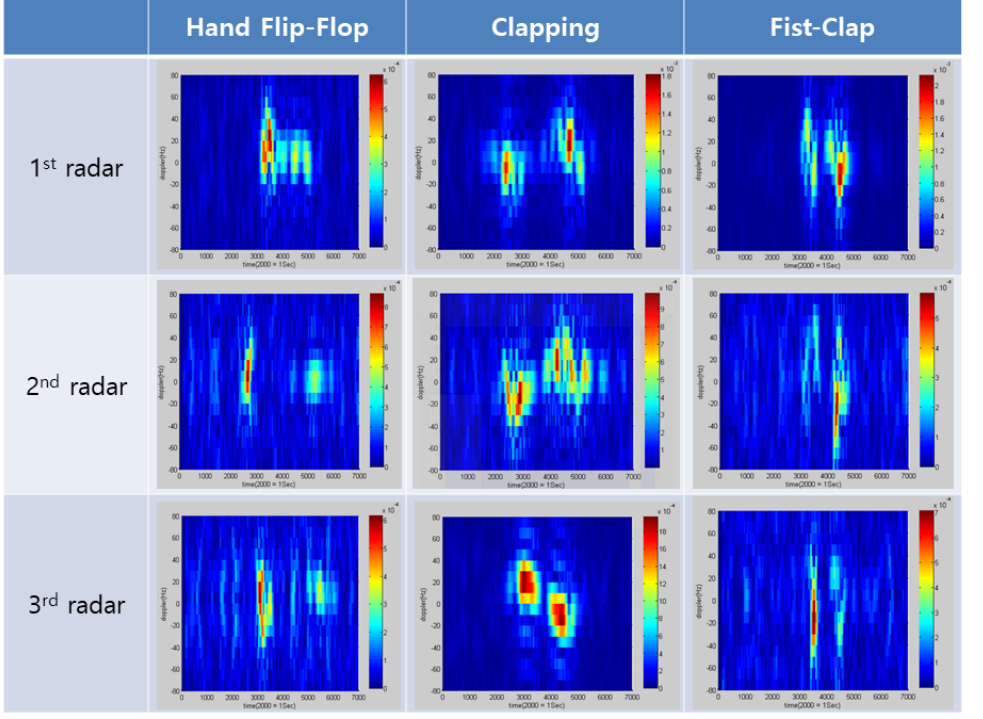
Figure 8. MD signatures of three different hand gestures at distributed radars.